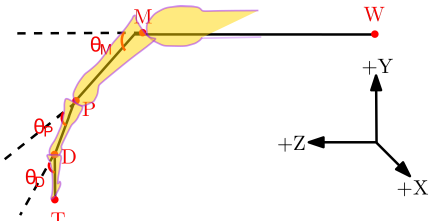
Figure 2. Geometrical sketch of a finger from the wrist joint depicting joint angles within the XYZ coordinate frame. The +X axis is from the ulna to radial styloid, the +Z axis from the midpoint of the wrist joint W to the metacarpal joint M and the +Y axis is the common line perpendicular to the X and Z